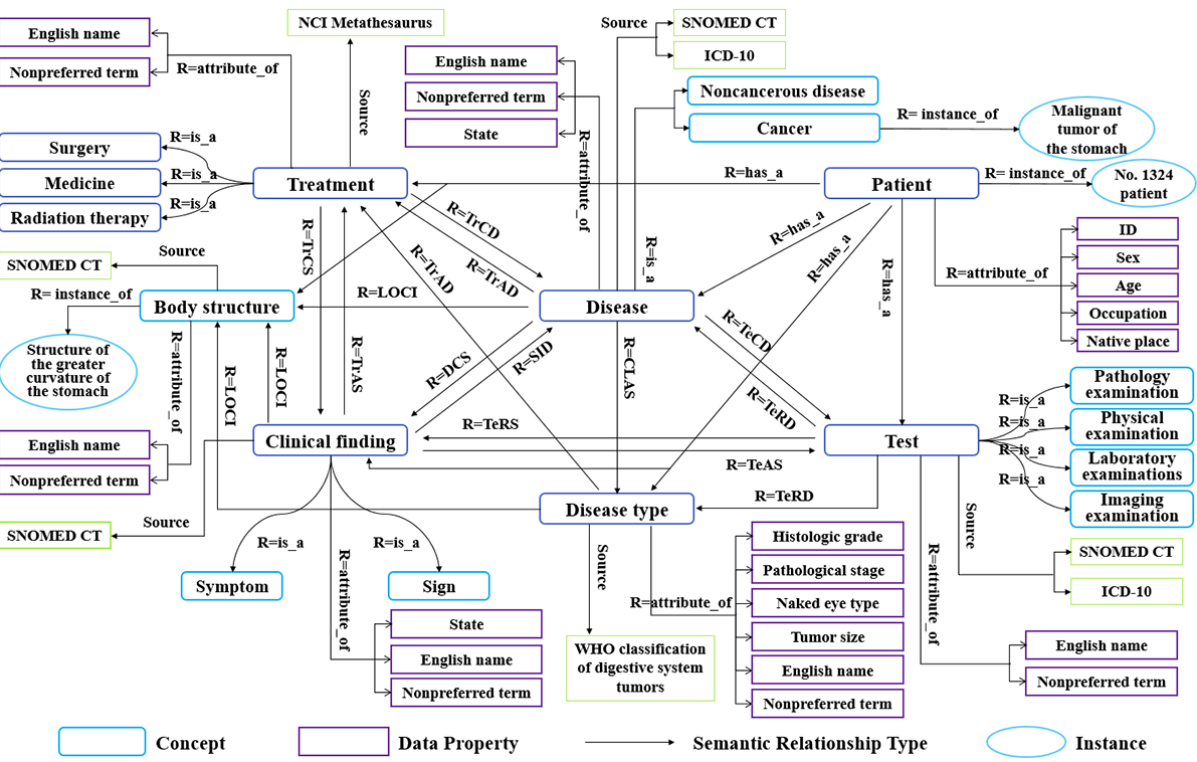
Figure 3. Schema of the digestive system tumor knowledge graph. CLAS: cancer disease type; DCS: disease causes symptoms and signs; ICD: International Classification of Diseases; LOCI: symptoms and signs are located in the body structure; NCI: National Cancer Institute; REST: representational state transfer; SID: symptoms and signs indicate the disease; SNOMED CT: Systematized Nomenclature of Medicine-Clinical Terms; TeCD: test is conducted to investigate the disease; TeRD: test reveals the disease; TeRS: test reveals the symptoms and signs; TrAD: treatment is administered for the disease; TrAS: treatment is administered for the symptoms and signs; TrCS: treatment causes the symptoms and signs; WHO: World Health